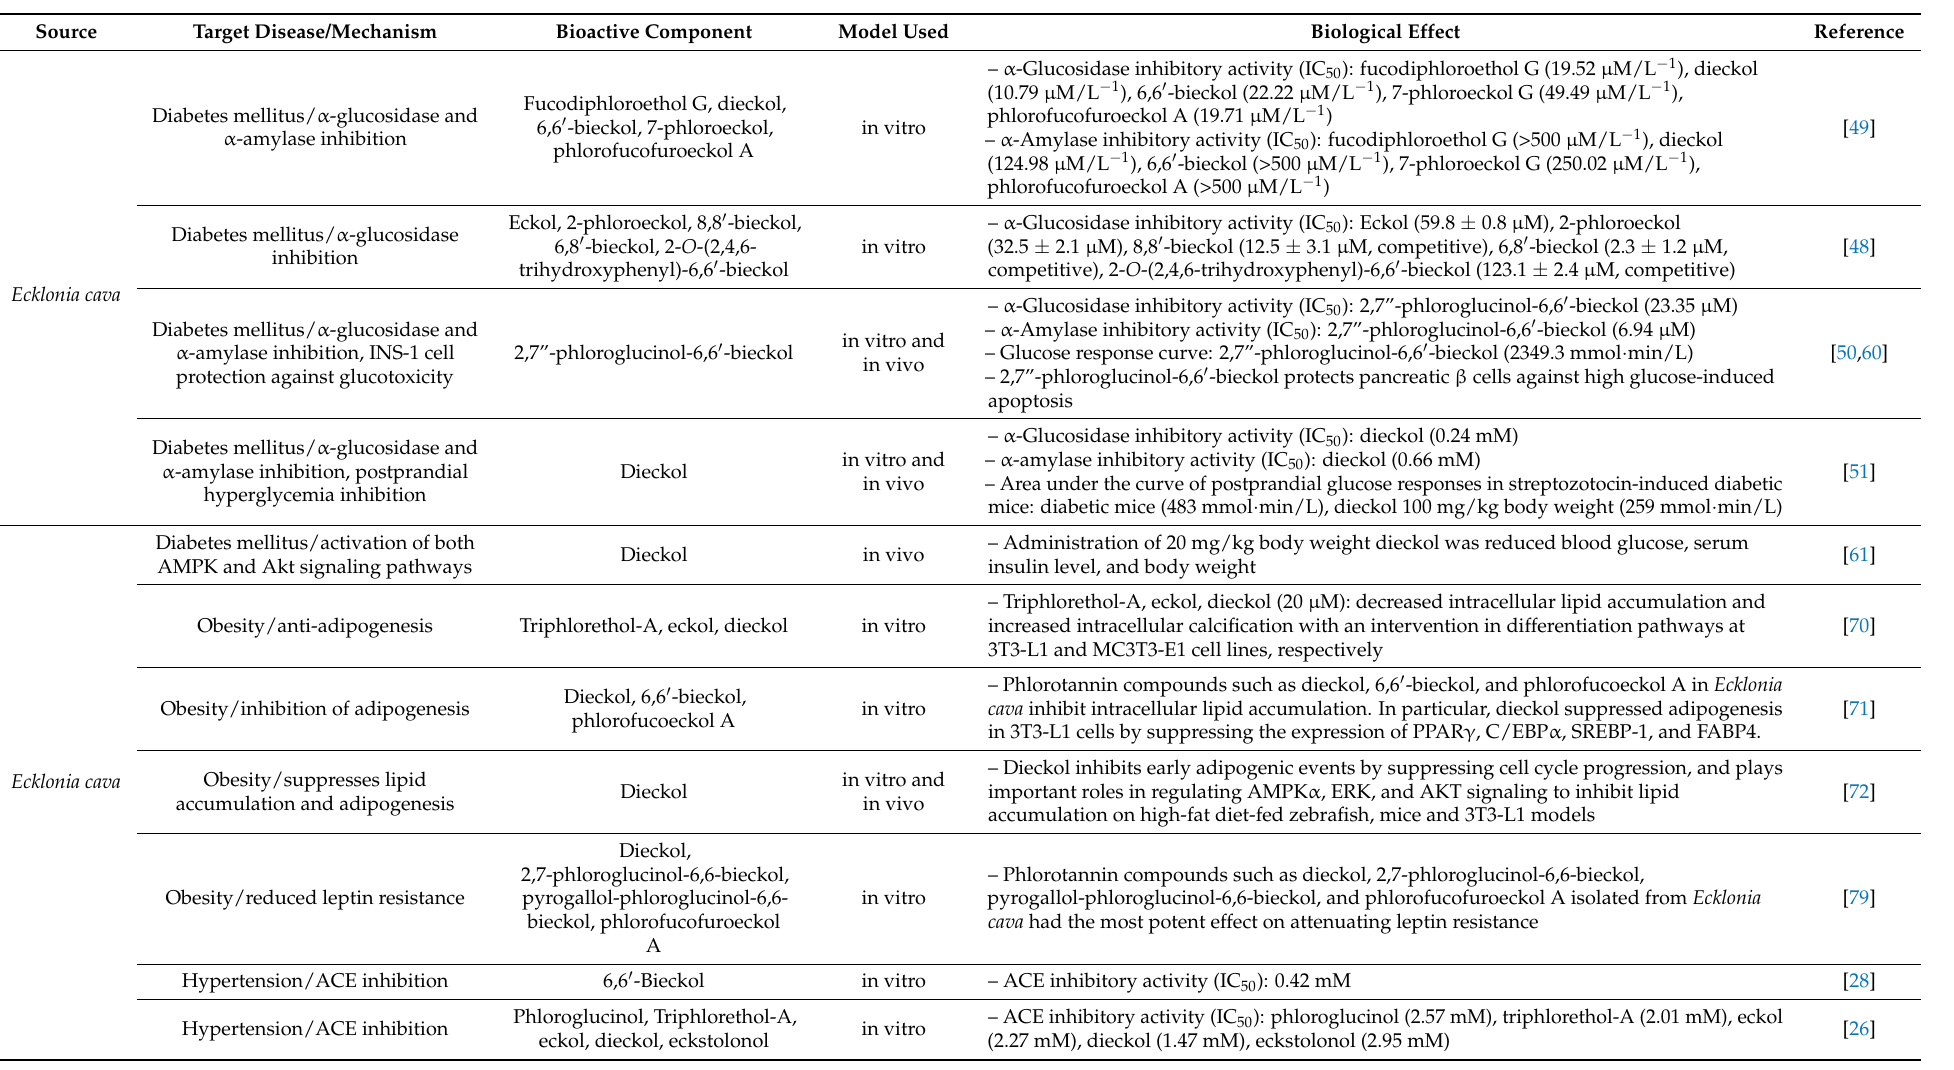
Table 1. Phlorotannin compounds isolated from seaweeds with therapeutic potential against cardiovascular